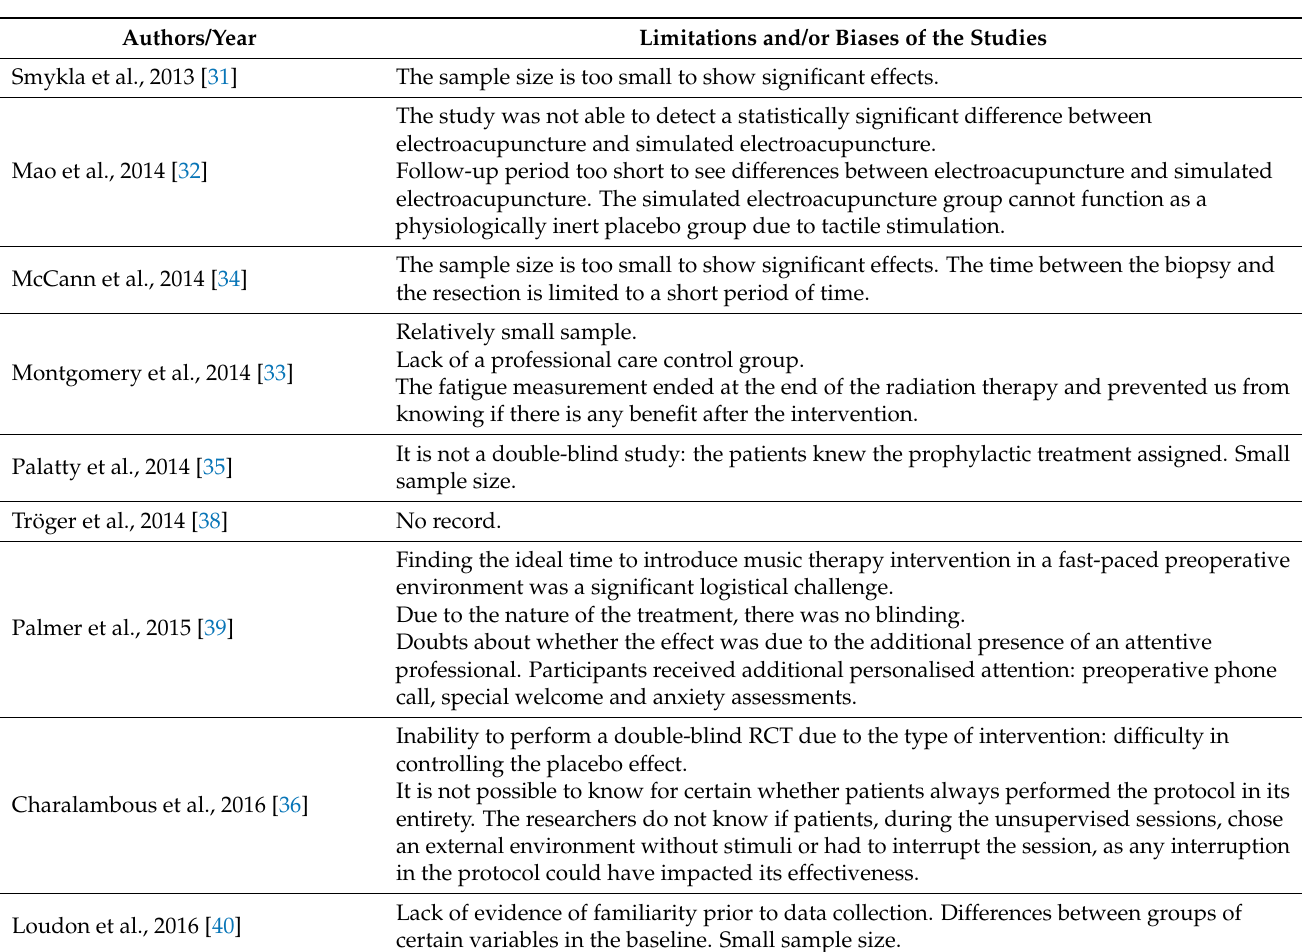
Table 1. Limitations and/or biases of the selected